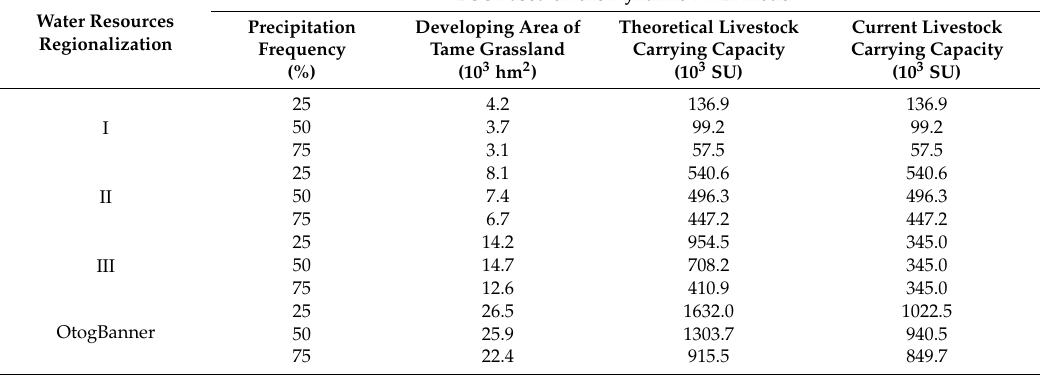
Table 5. LCC based on the Dynamic WFLB in OtogBanner.